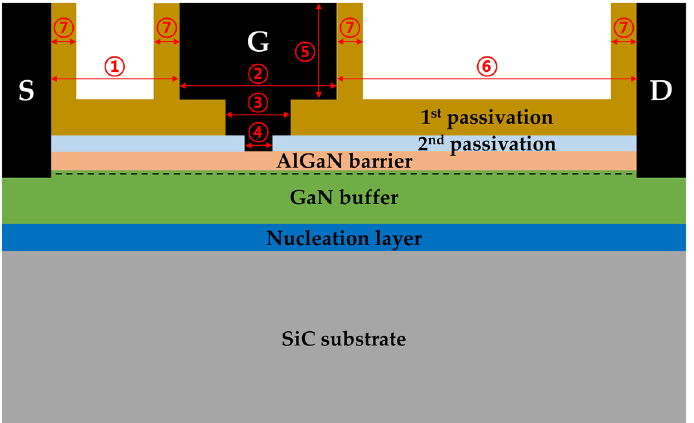
Figure 2. A cross-sectional schematic of the basic T-gate AlGaN/GaN HEMT used in the modeling. The S, D, and G stand for source, drain, and gate electrode, respectively, and the numbers are explained in the Table 1. Table 1. Geometrical parameters of the basic T-gate structure and epitaxial layer used in the simulation.